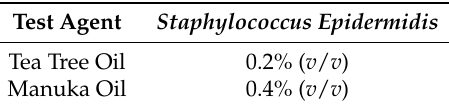
Table 5. Varying concentrations of antimicrobial solutions.